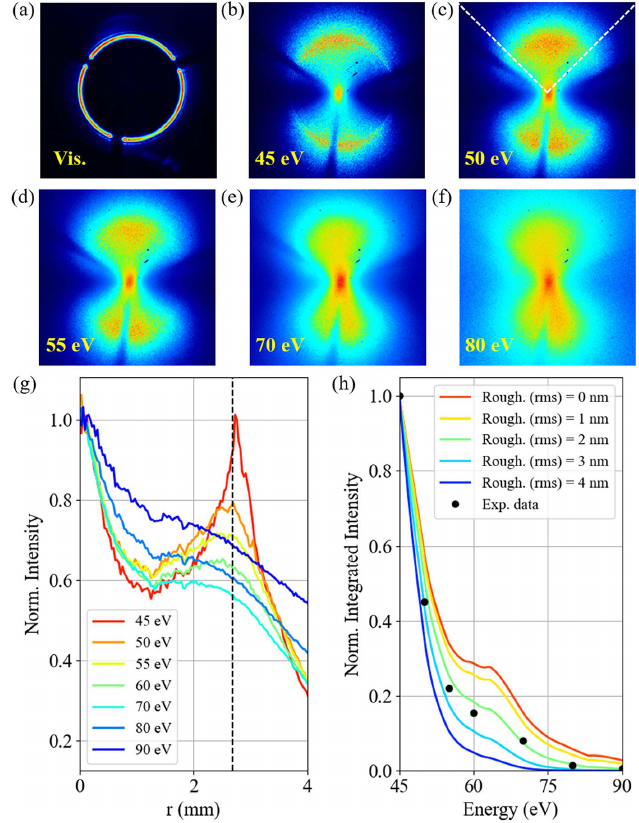
Figure 2 ( a ) Recorded intensity pattern obtained with unpolarized visible light. A circular ring-like structure is clearly visible. ( b )–( f ) Recorded intensity patterns obtained with LH polarized light of increasing photon energy, as stated in the labels. The colour bar limits are different for each panel, and they have been chosen to better highlight the features of interest. ( g ) Radial profiles extracted from the region contained between the two white dashed lines in ( c ). All the profiles are normalized to the intensity at the centre of the image ( r = 0). The vertical black dashed line highlights the average radius of the circular structure in ( a ). For increasing energy, the amplitude of the peak corresponding to the ring-like feature decreases, while its width is enhanced. ( h ) Normalized integrated intensity as a function of the photon energy. The black dots represent the experimental data, while the continuous coloured lines show the predicted energy dependence of the COMIX transmittance for mirror roughnesses in the 0–4 nm (r.m.s.)